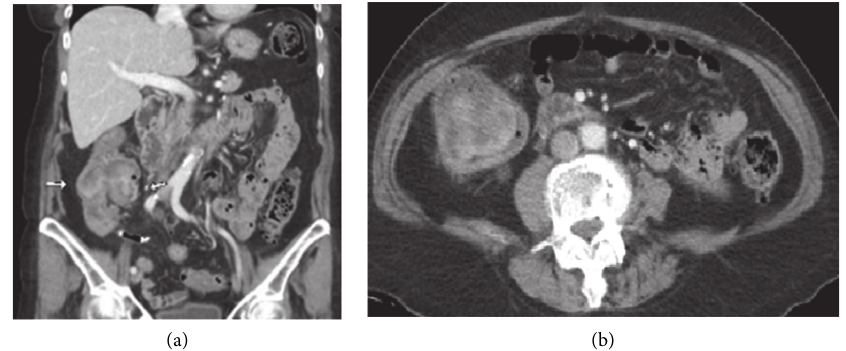
Figure 1: Right ascending mass in ascending colon CT. (a) (Arrows) colo-colonic intussusception with associated submucosal edema. (b) Right colonic mass measuring approximately 7cm.